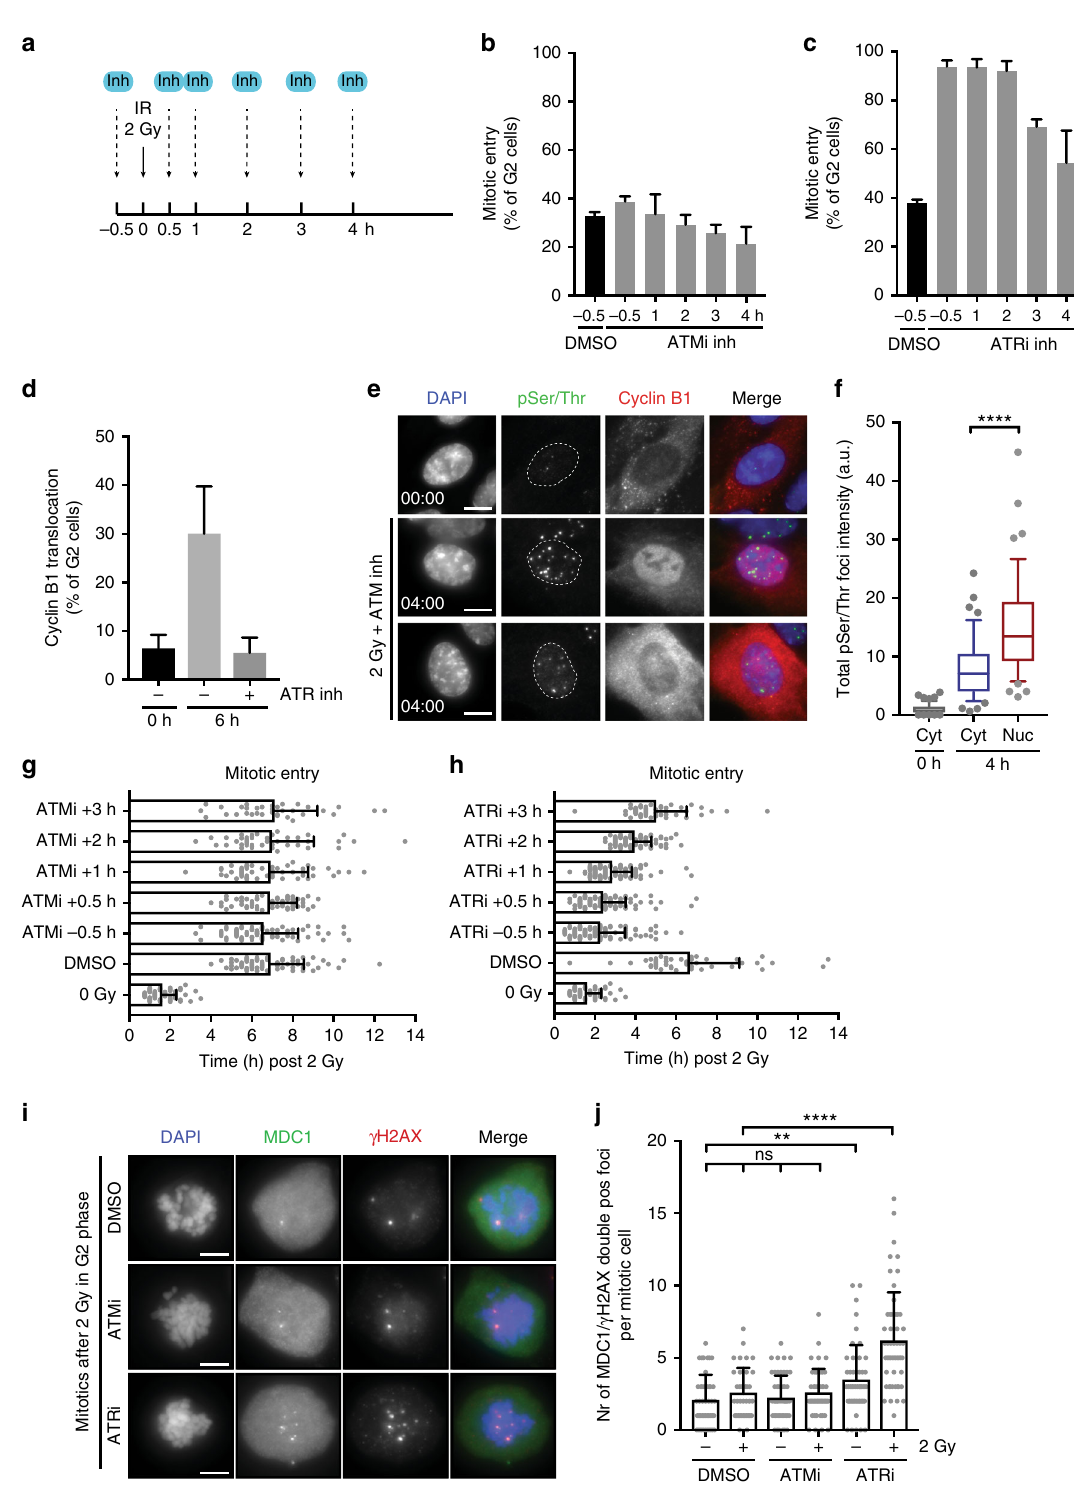
after 4 h of OHT treatment, while this was unaffected when OHT treatment was combined with ATR inhibition (Supplementary Fig. 2f). Quanti fi cation of Cyclin B1 localization in G2 cells 6 h after OHT addition, shows that ~30% of the cells